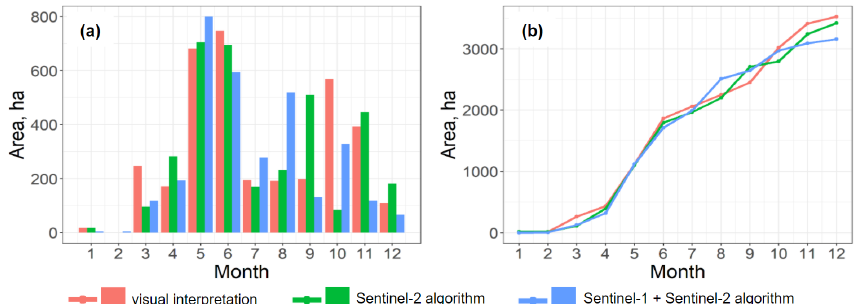
Figure 11. The sugarcane areas harvested by month, identified by visual interpretation (lv), algorithm based on optical data (optic), algorithm based on Synthetic Aperture Radar (SAR) and optical data (sar): ( a ) absolute values; ( b ) accumulated